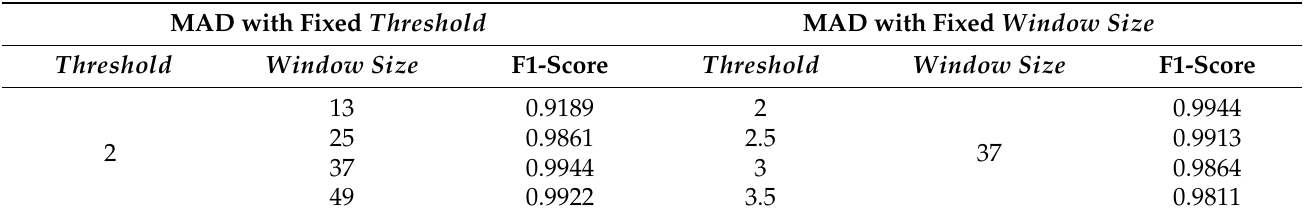
Table 4. F1-score sensitivity resulting from MAD method after varying Threshold and Window size parameters for station 1. MAD with Fixed